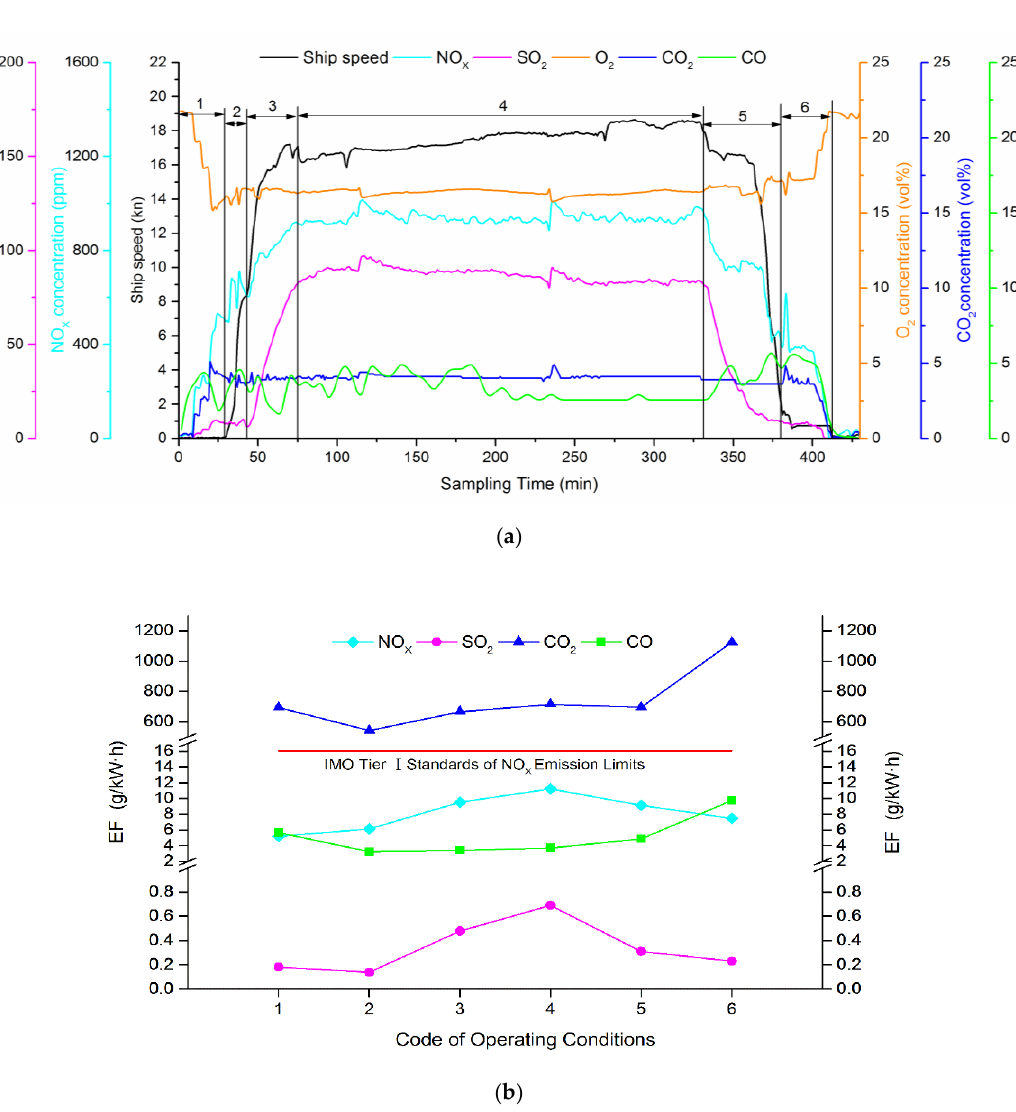
Figure 4. ( a ) The relation between the gas emission concentration and the ship speed under different operating conditions over the entire experiment. ( b ) The average emission factors (EFs) based on the power of the main engine for the pollutants under different ship conditions. The operating conditions are (1) berthing, (2) manoeuvring in port, (3) acceleration, (4) cruising, (5) deceleration, and (6) anchoring.